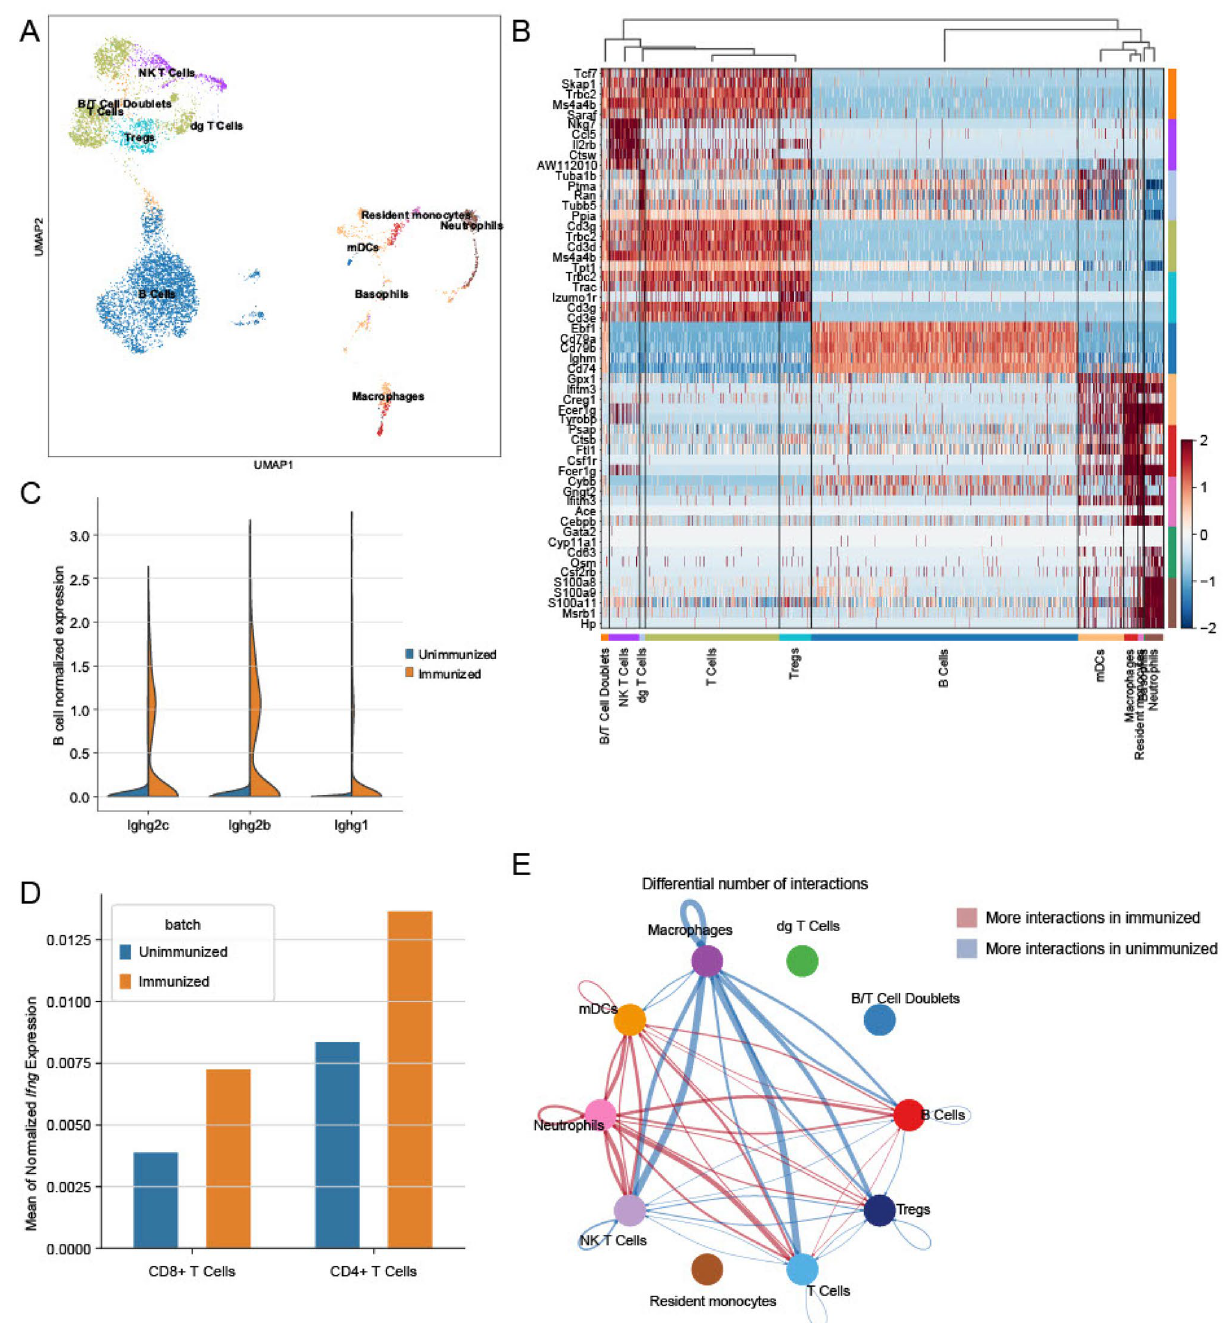
Figure 8. Analysis of single cell transcriptomic data in unimmunized and H5/IVAX-1 immunized mice. C57Bl/6 female mice (N = 3) were administered 5 μg H5 in 50μL IVAX-1 adjuvant s.c. and boosted on d14 (s.c.) and d28 (i.p.), and spleens collected 7 days later. Splenocytes from a single age-matched naïve mouse were also prepared for comparison. ( A ) UMAP visualization of splenocytes before and after vaccination shows transcripts are derived mostly lymphoid lineage with some myeloid cells. ( B ) Heatmap of differential expression testing; the highest differentially expressed genes for most major populations are their marker genes (see text for details). Each column represents a single cell. ( C ) Expression of B cell Ighg2c, Ighg2b and Ighg1 genes is elevated after immunization, with more IgG2 transcripts compared to IgG1. ( D ) Mean expression of Ifng gene in CD8+ and CD4+ T cells before and after immunization showing upregulation in both subsets. ( E ) Circular plot showing the main cell–cell interactions in pre- and post-vaccination splenocytes (blue and red lines,